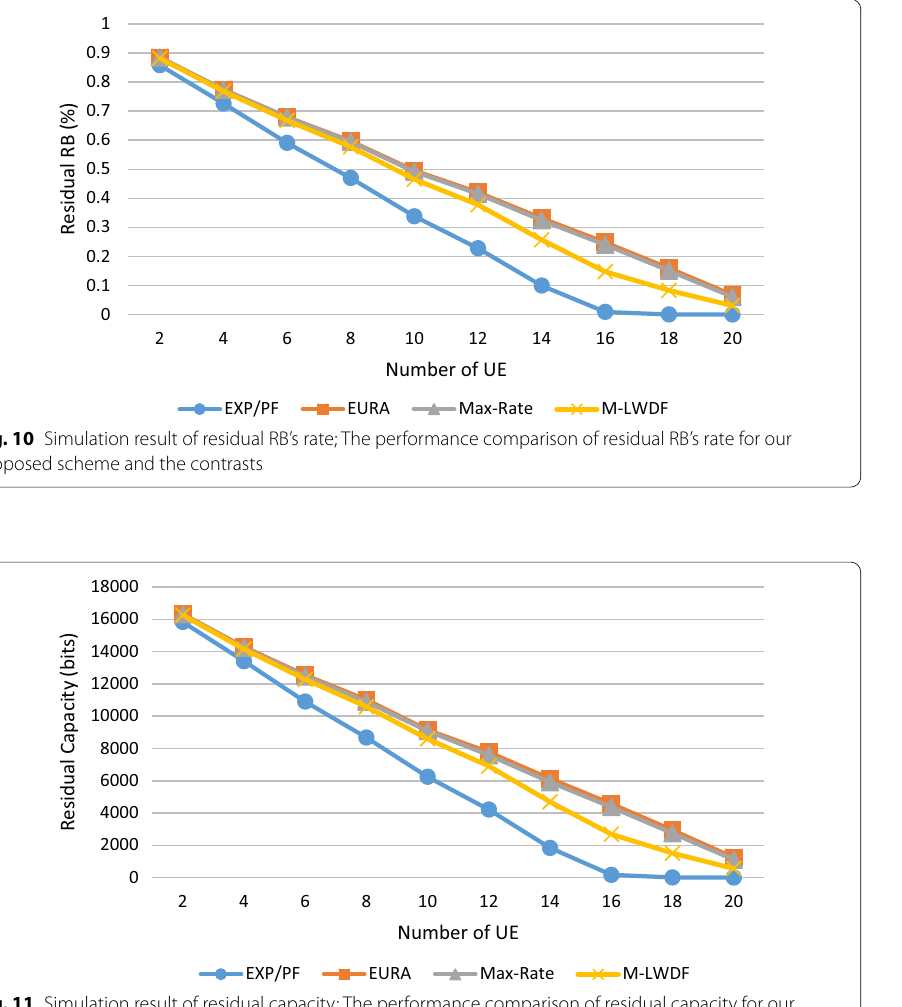
Fig. 11 Simulation result of residual capacity; The performance comparison of residual capacity for our proposed scheme and the